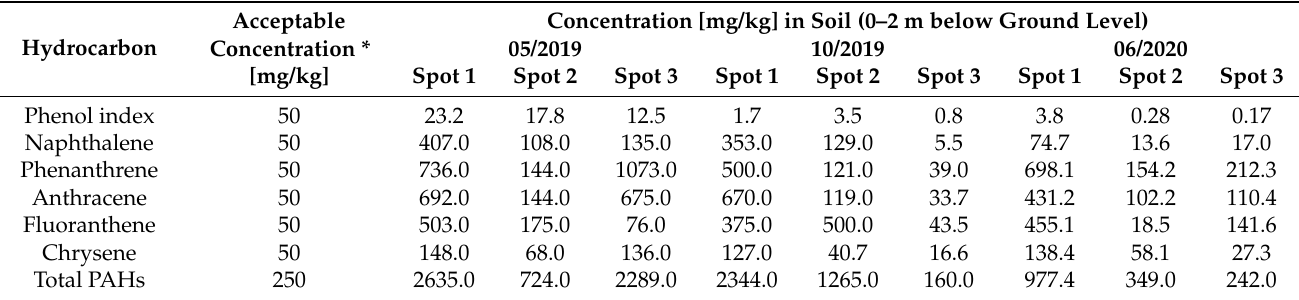
Table 3. Hydrocarbon concentration in soil (3 spots).